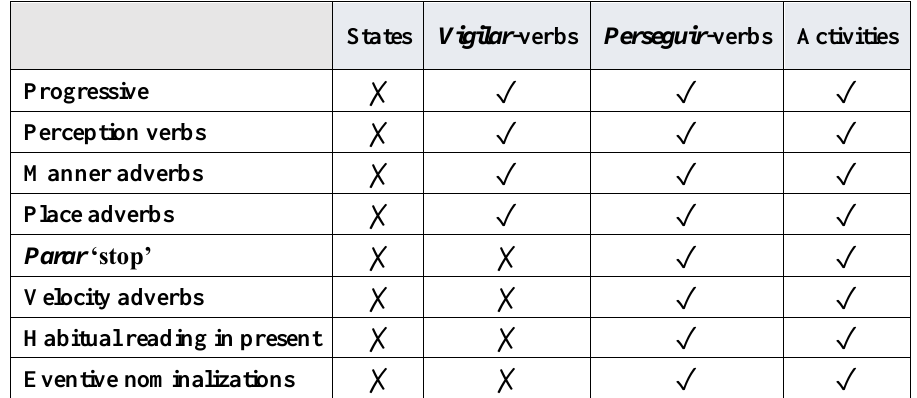
Table 1. Aspectual contrasts between vigilar -verbs and perseguir